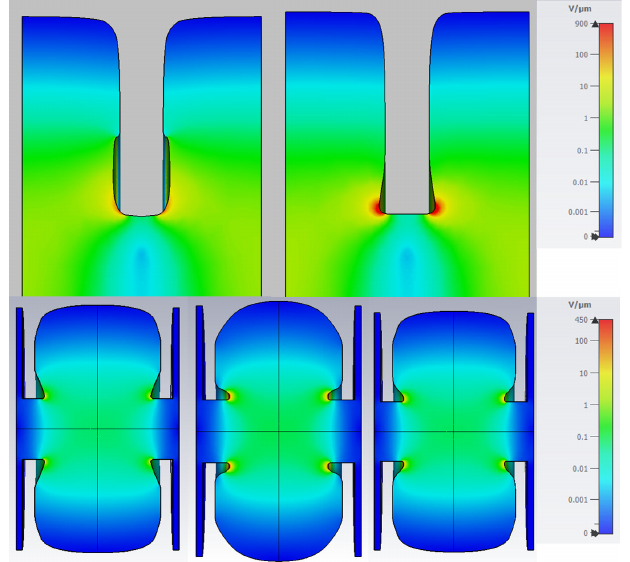
FIG. 27. Two potential final designs for an X-band TW single cell, chosen using clustering and the PCP visualization method [top from left to right: S1 (low E and a C-band SW single cell, chosen using the DM method [bottom from left to right: S1 (low S3 (trade-off between Z and absolute value of the electric field for 1 J stored